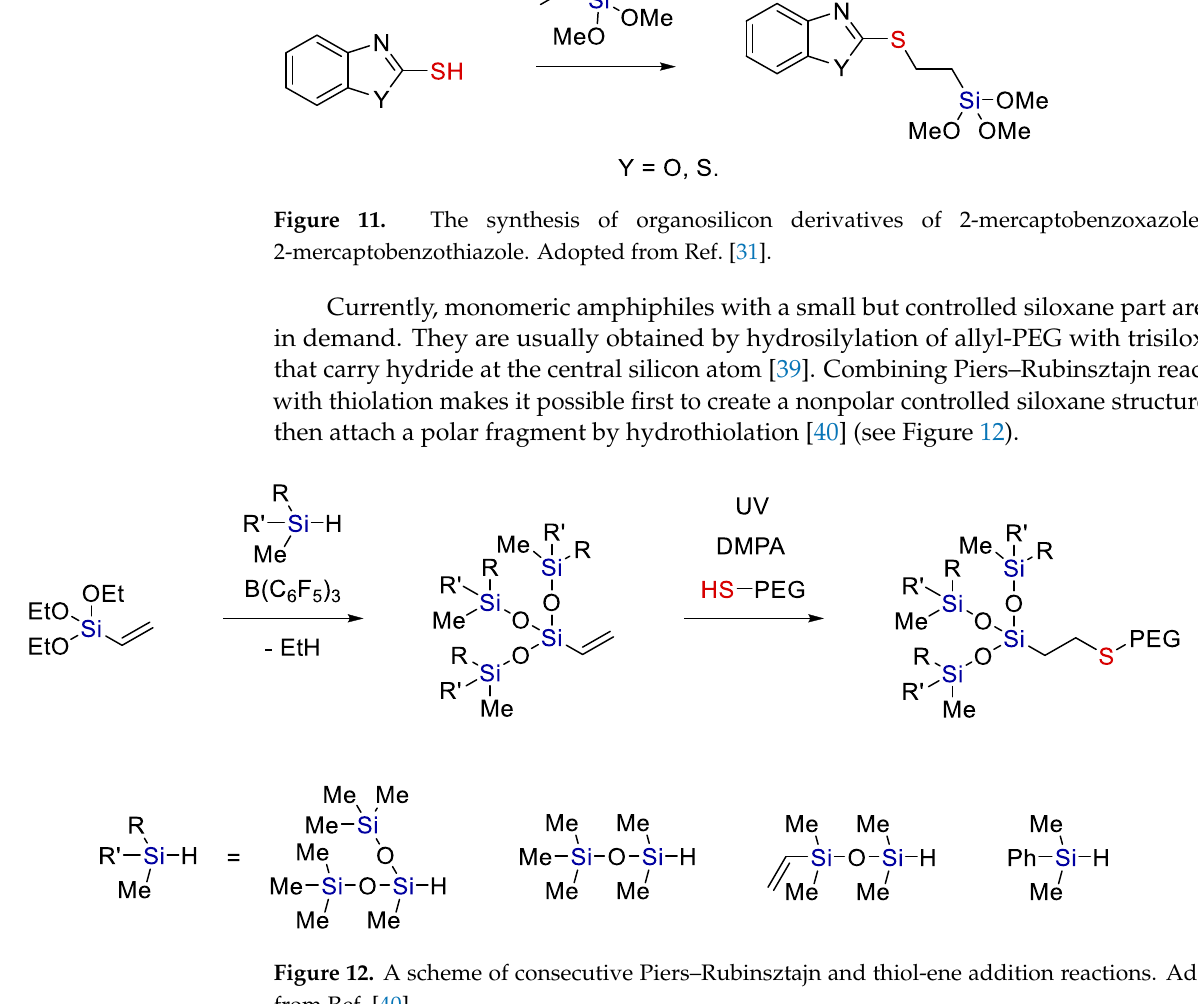
Figure 11. The synthesis of organosilicon derivatives of 2-mercaptobenzoxazole and 2-mercapto- benzothiazole [31].